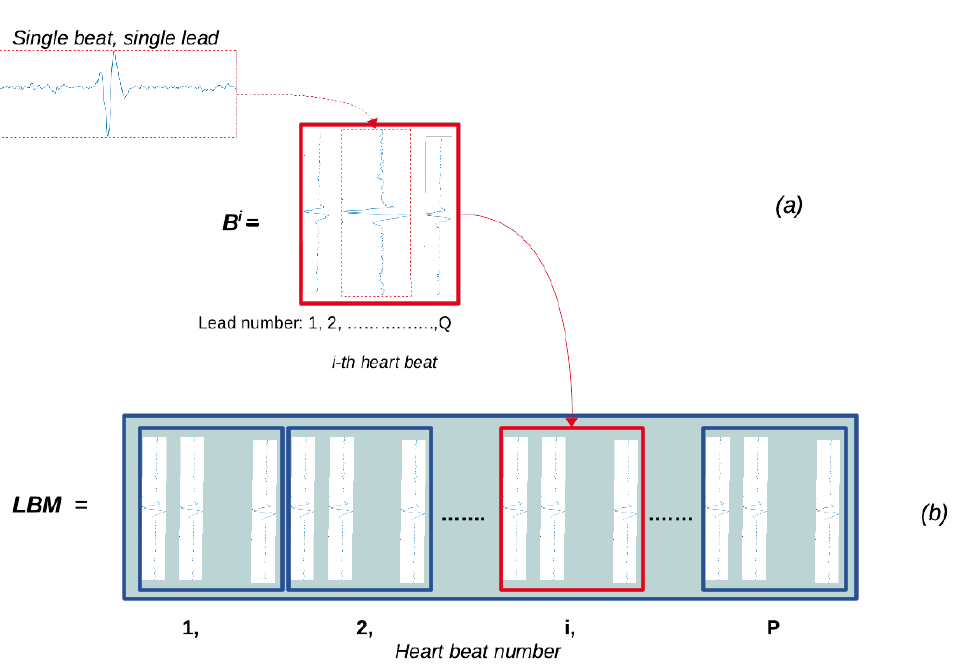
Figure 3. ( a ) Schematic representation of the B i matrix composition; and ( b ) schematic representation of the LBM matrix for one generic HR-ECG record.